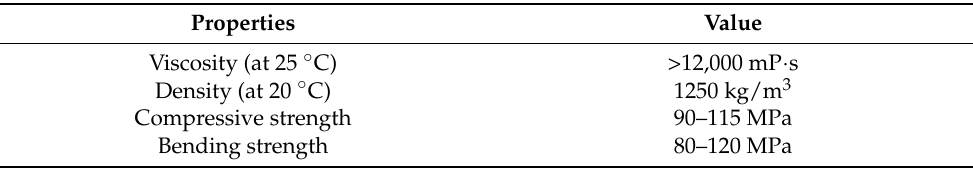
Table 3. Selected properties of epoxy adhesive